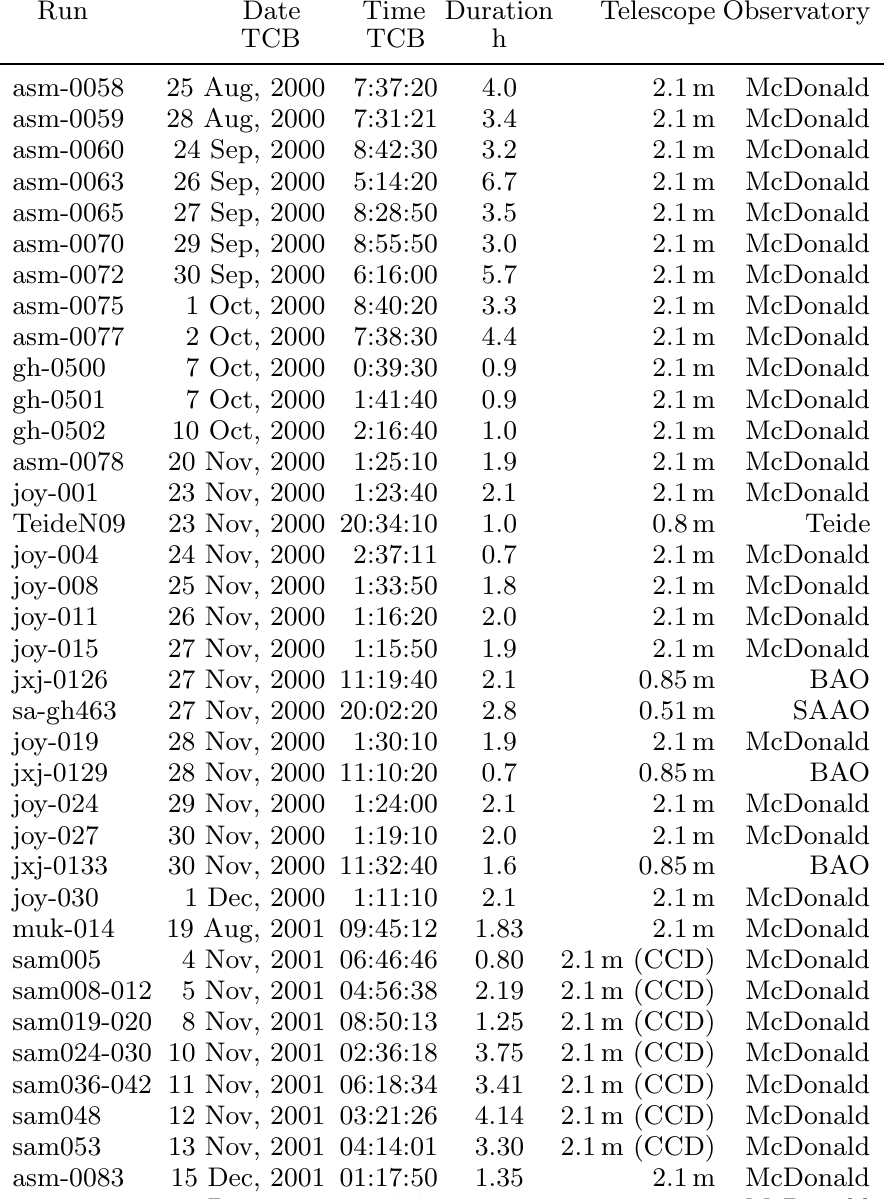
Table 1. Journal of observations for ZZ Ceti data from 1999, 2000 and 2001